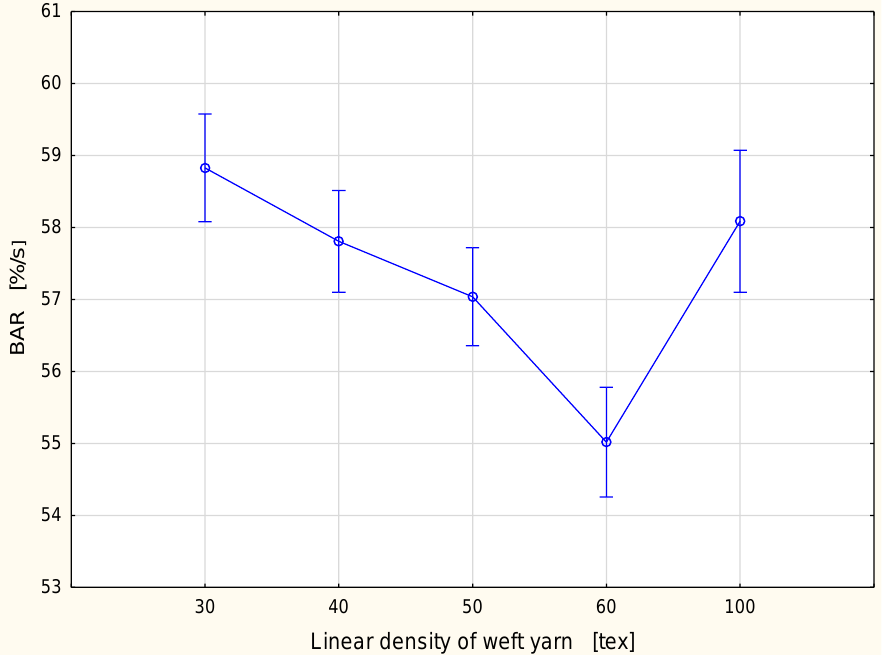
Figure 9. Absorption rate for the bottom fabric surface vs. linear density of the weft yarn. The biggest maximum wetted radius was found for the fabric variant with the 30 tex weft yarn (Figures 10 and 11). The values were the following: the MWRT was 25.0 mm and the MWRB 26.5 mm. The lowest values of the maximum wetted radius occurred for the fabric variants with the 100 tex and 60 tex weft yarns. For both fabric surfaces, the maximum wetted radius was 20.0 mm. On both surfaces, the maximum wetted radius decreased with the increase of the linear density of the weft yarn. This was according to our expectations. Coarser weft yarn means a larger share of fibrous material in the fabric structure. As was mentioned, the investigated fabrics were made of cotton, which is hydrophilic. A larger amount of cotton causes more intensive absorption of liquid and retention of liquid inside the fibers. This is not conducive to the spread of fluid over the surfaces.